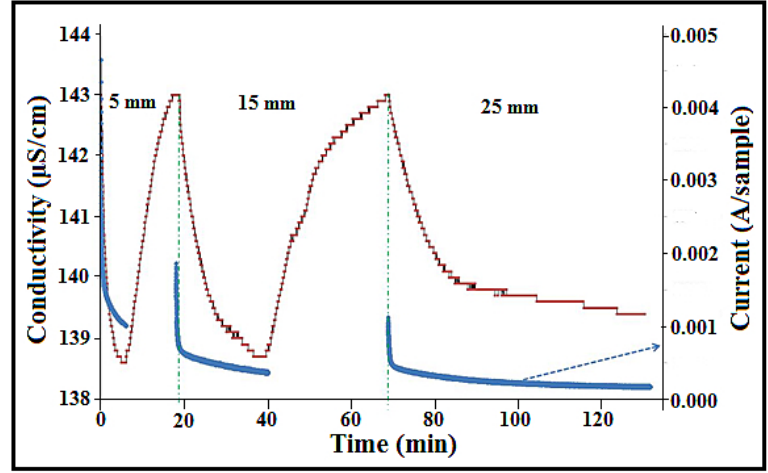
Figure 8. The effect of distance between the electrodes (5 mm, 15 mm, and 25 mm) on the current and conductivity behaviour of the 23.58 wt% a-SWCNT-coated RVC electrode measured at a voltage of 1.5 V and a flow rate of 50